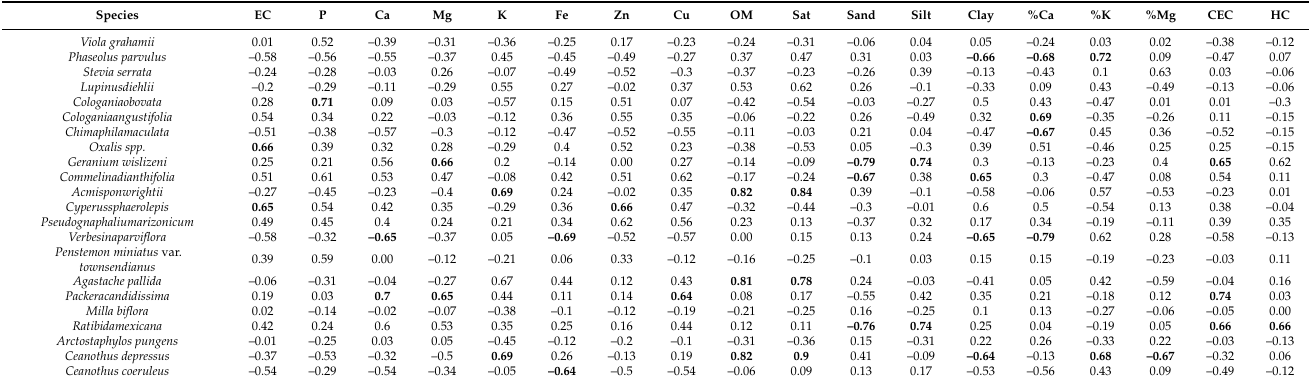
Table 3. Spearman correlation analysis between soil properties and plant species obtained for the Binomial Logistic Regression